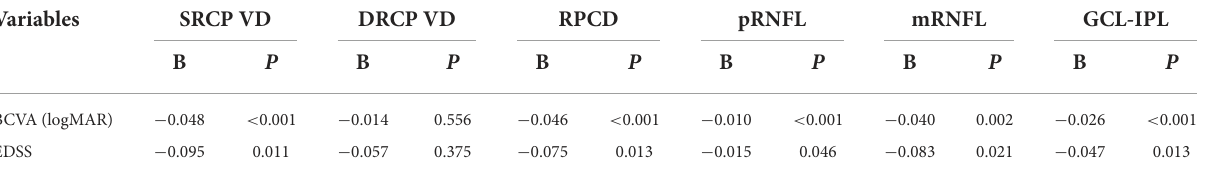
TABLE 3 The correlation between on OCT and OCTA parameters and clinical